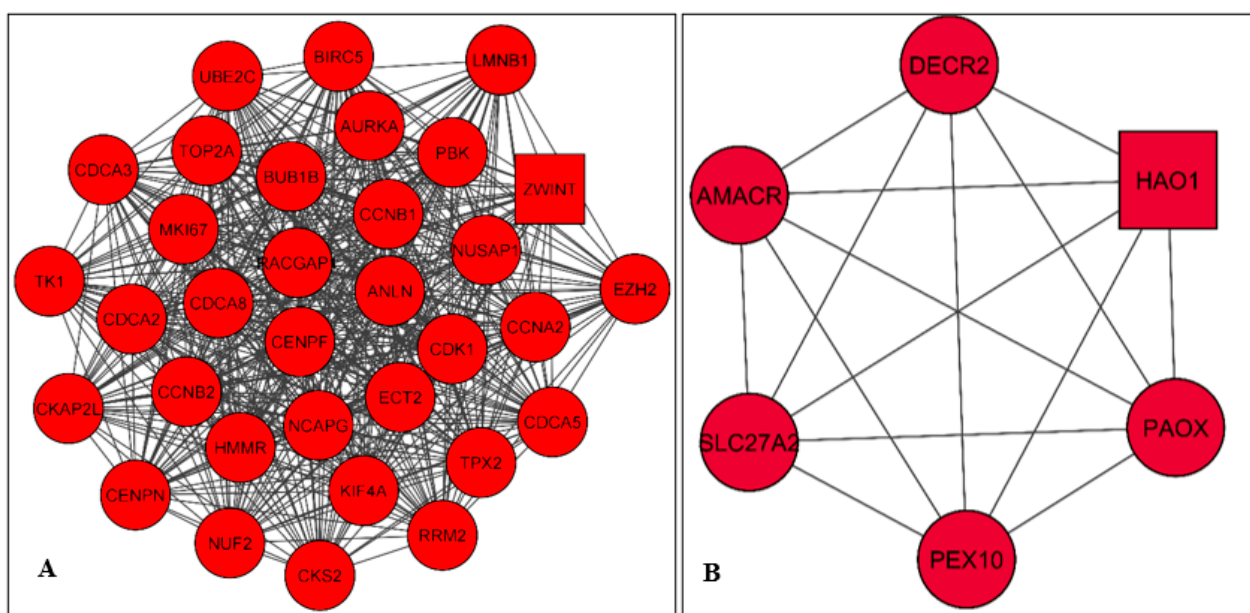
Figure 4. The two modules were generated from the DEGs PPI network by MCODE. ( A ) Module-1: associated with a score of 31.9, and includes 33 genes (nodes) and 511 edges. ( B ) Module-2: associated with a score of 6.0, consists of 6 genes (nodes) and 13 edges. Includes the top five clustered proteins (PEX10, SLC27A2, AMACR, PAOX, and DECR2), and one seed protein (HAO1) which is emphasized in the square node shape.